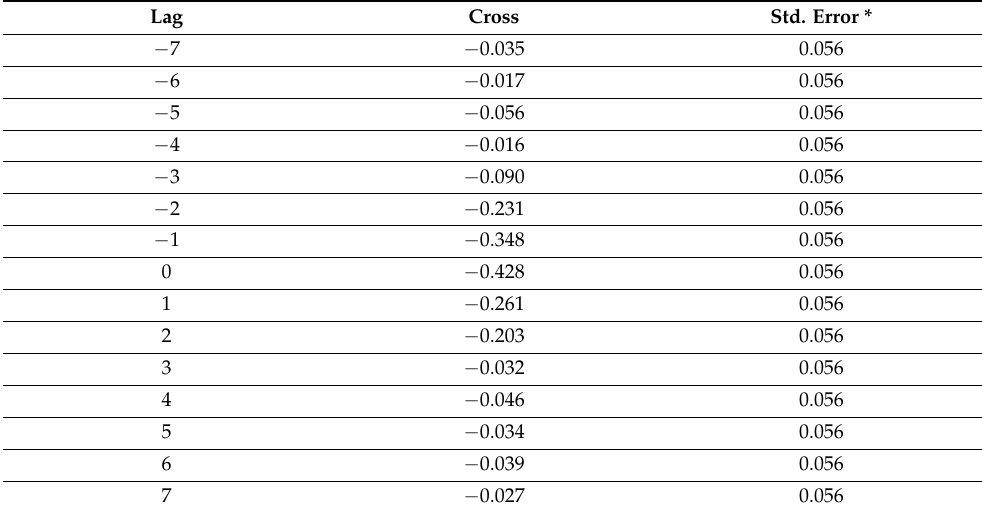
Table 2. Estimated cross-correlation between the total number of sickness days per company and the FTE/week.